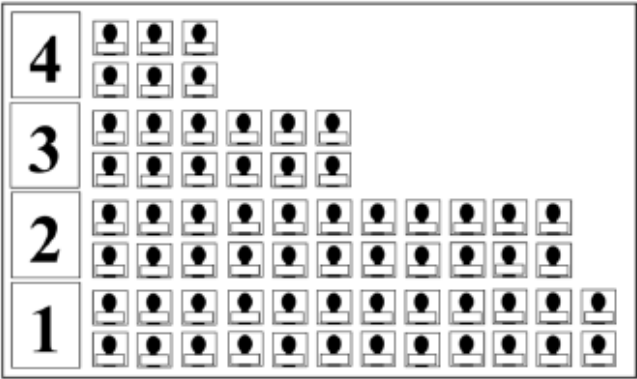
Figure 10. Depiction of Safety Board in UWAFT Bay (Main Office) [5].